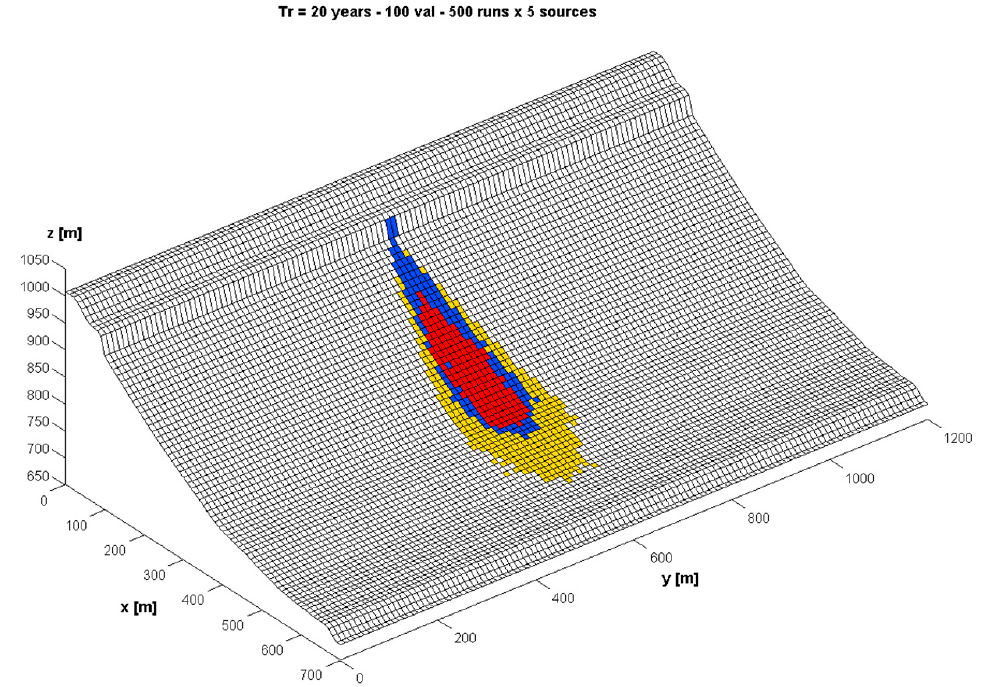
Figure 5. Hazard zoning for a single source problem, performed according to the Swiss Guidelines, for a failure frequency of λ f, 2 D = 0.02 (years − 1 · m − 2 ), i.e., λ f,cell = 2 years − 1 . Red : high hazard zone; blue : moderate hazard zone; yellow : low hazard zone.